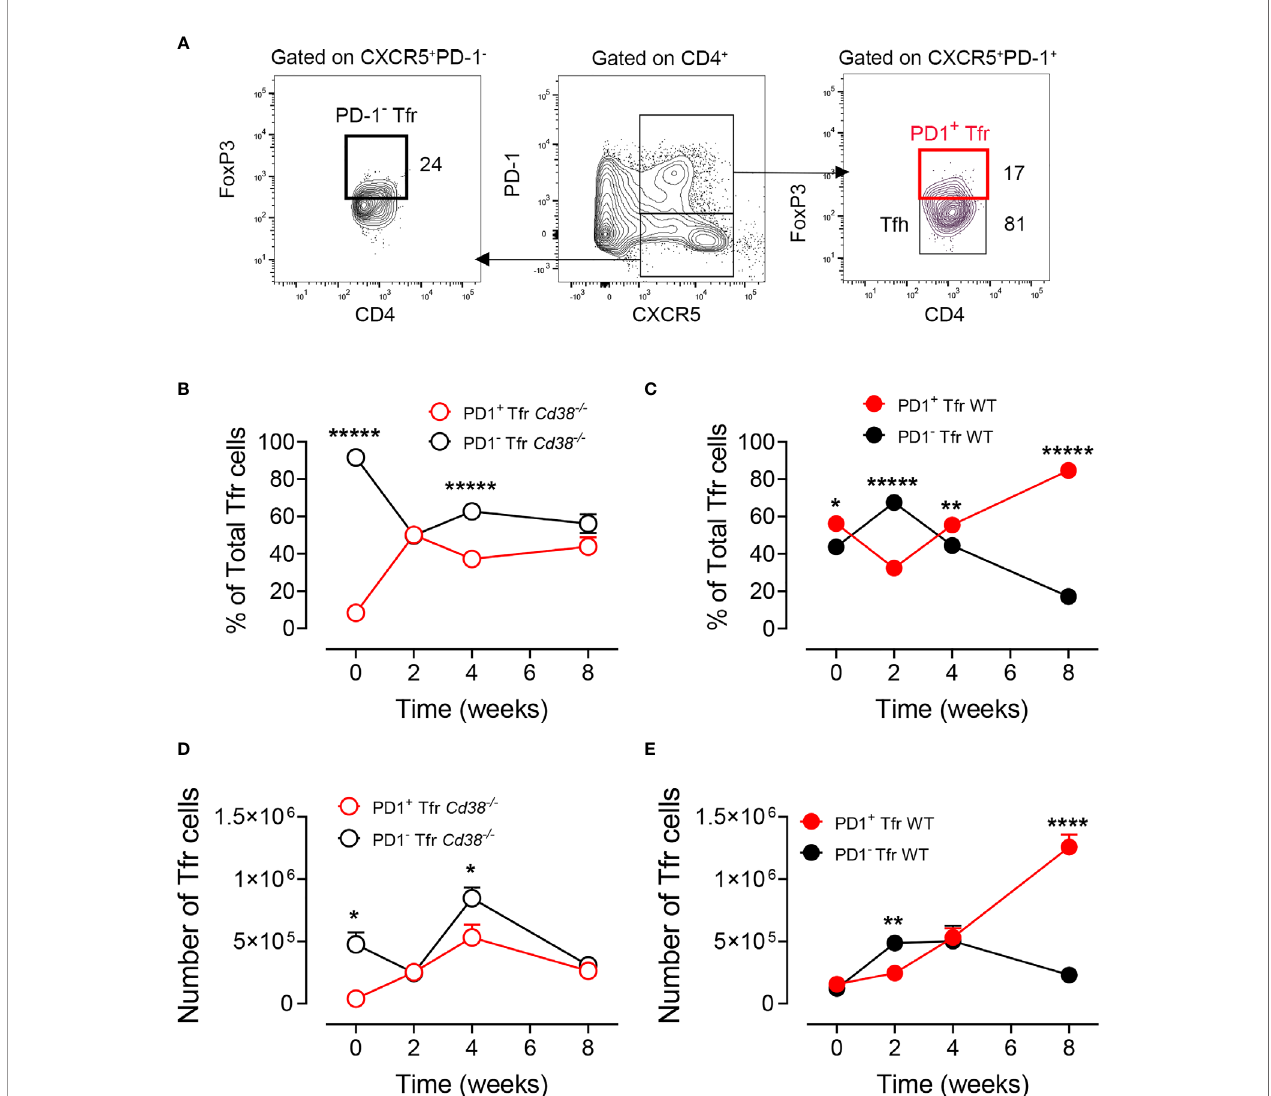
FIGURE 5 | Distinct kinetic pro fi les of PD-1 + and PD-1 − Tfr cells in cGVHD Cd38 − / − versus cGVHD WT mice. (A) Gating strategy to detect PD-1 hi CXCR5 + FoxP3 + or PD1 − CXCR5 + FoxP3 + Tfrs cells in spleen cells from cGVHD mice. Left panel: FoxP3 versus CD4 plot of gated CD4 + CXCR5 + PD-1 − cells, showing the frequency of the PD- 1 − FoxP3 + Tfr cells. Middle panel: PD-1 versus CXCR5 plot on gated CD4 + cells showing the gated CXCR5 + PD-1 hi and CXCR5 − PD-1 − subpopulations. Right panel: FoxP3 versus CD4 plot showing the frequencies of PD-1 + FoxP3 + Tfr cells and PD-1 − FoxP3 − Tfr cells. (B) Kinetics of the frequencies of PD1 + (open red circles) and PD-1 − (open black circles) Tfr cells relative to total Tfr cells in spleen cells from cGVHD Cd38 − / − mice. (C) Kinetics of the frequencies of PD1 + (closed red circles) and PD-1 − (closed black circles) Tfr cells relative to total Tfr cells in spleen cells from cGVHD WT mice. (D) Kinetics of total numbers of PD1 + (open red circles) and PD-1 − (open black circles) Tfr cells relative to total Tfr cells in spleen cells from cGVHD Cd38 − / − mice. (E) Kinetics of total numbers of PD1 + (closed red circles) and PD-1 − (closed black circles) Tfr cells relative to total Tfr cells in spleen cells from cGVHD WT mice. The symbols are the mean values and the vertical bars represent ± SEM. P -values are shown for Welch ’ s t -test. The results are cumulative data from two to three different experiments per time point and mouse type, each with three to four mice per experiment. * P < 0.05, ** P < 0.01, **** P < 0.0001, ***** P <